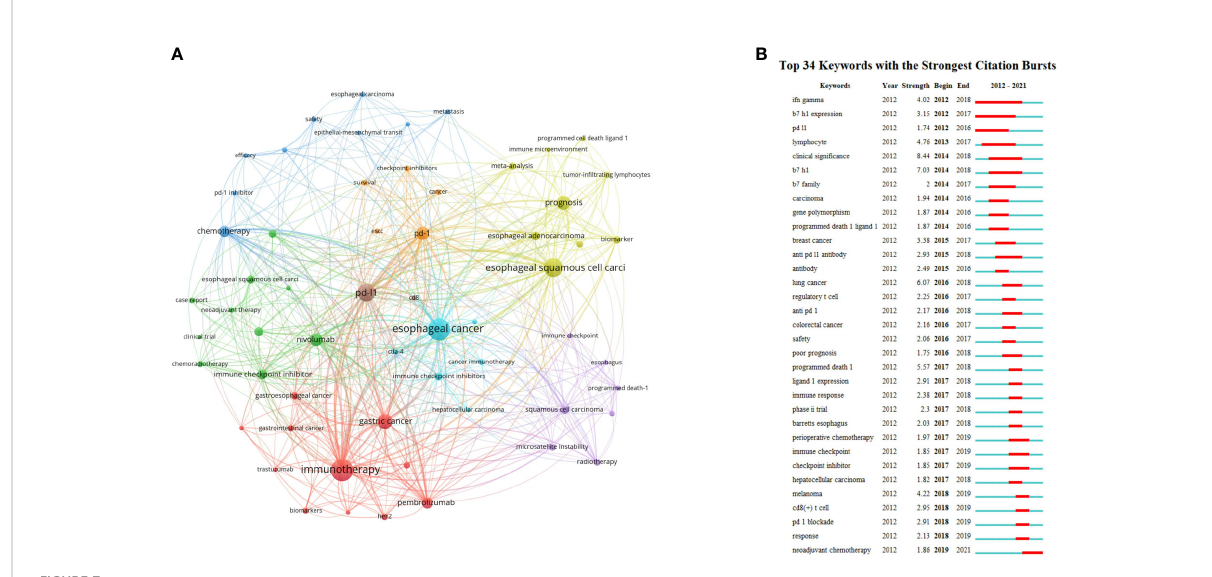
FIGURE 7 (A) The co-occurrence network visualization map of keywords. Keywords in the same color represent were sorted into the same cluster. (B) The top 34 keywords with the strongest citation bursts from 2012 to 2021. The red segment of the blue line denoted the burst duration of a